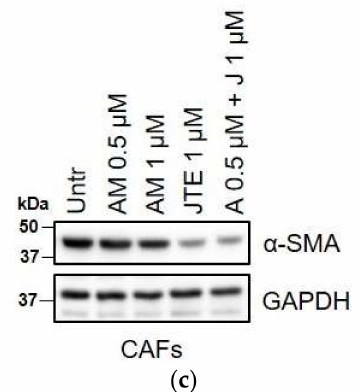
Figure 5. The endocannabinoids a ff ect the migration abilities of androgen-insensitive prostate cancer cells and CAFs’ reactivity by autocrine self-sustaining loops. ( a , b ) 3 × 10 4 PC-3 (left) or DU-145 (right) cells were pre-treated for 24 h with di ff erent concentrations of AM281 and JTE-907 administrated alone or in combination. Tumor cells were allowed to migrate for 16 h towards complete medium (10% FBS). Cells maintained in serum-deprived medium were used as controls (Untr). Data represent means ± SEMs of three independent biological replicates. *** p < 0.001 versus Untr. ( c ) Representative immunoblot of α -SMA expression on CAFs treated with di ff erent concentrations of CBs antagonists, administrated alone or in combination, for 24